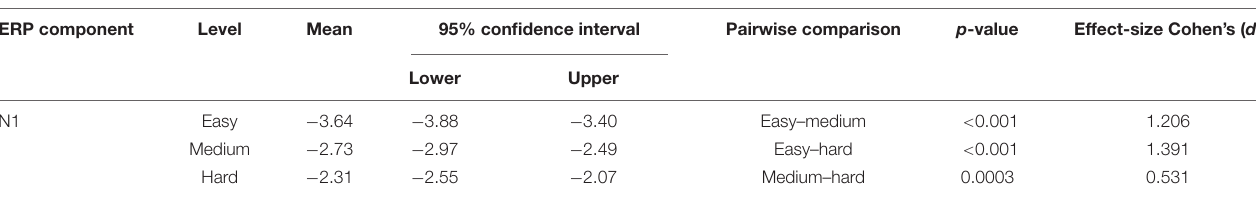
TABLE 1 | Table shows the mean values and effect sizes from the post-hoc